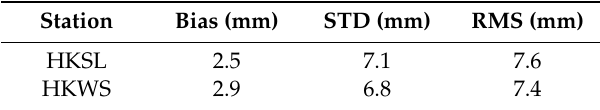
Table 1. Bias, standard deviation (STD), and root mean square (RMS) of the di ff erences between the RT-ZTD and IGS-ZTD time series shown in Figure